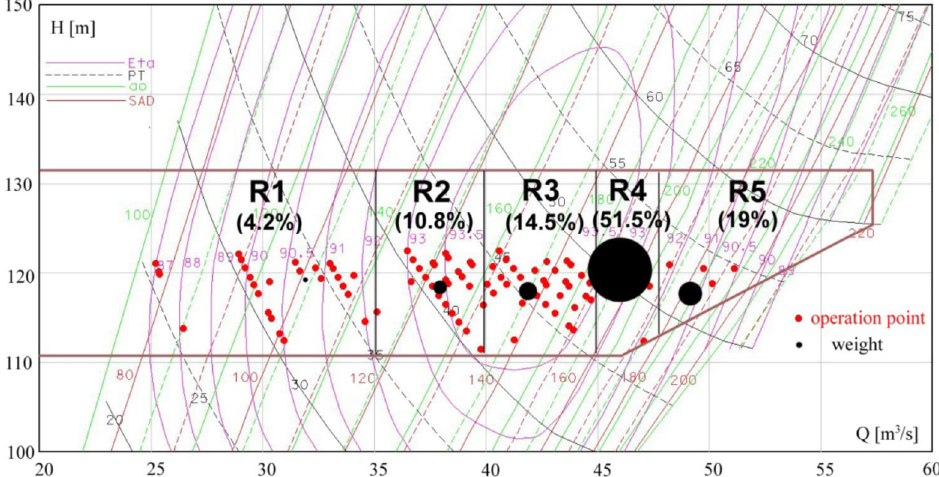
Fig. 1. Francis turbine hill chart together with fi ve control regimes selected based on one decade operation (1999 – 2009) of both units available in the hydropower plant.